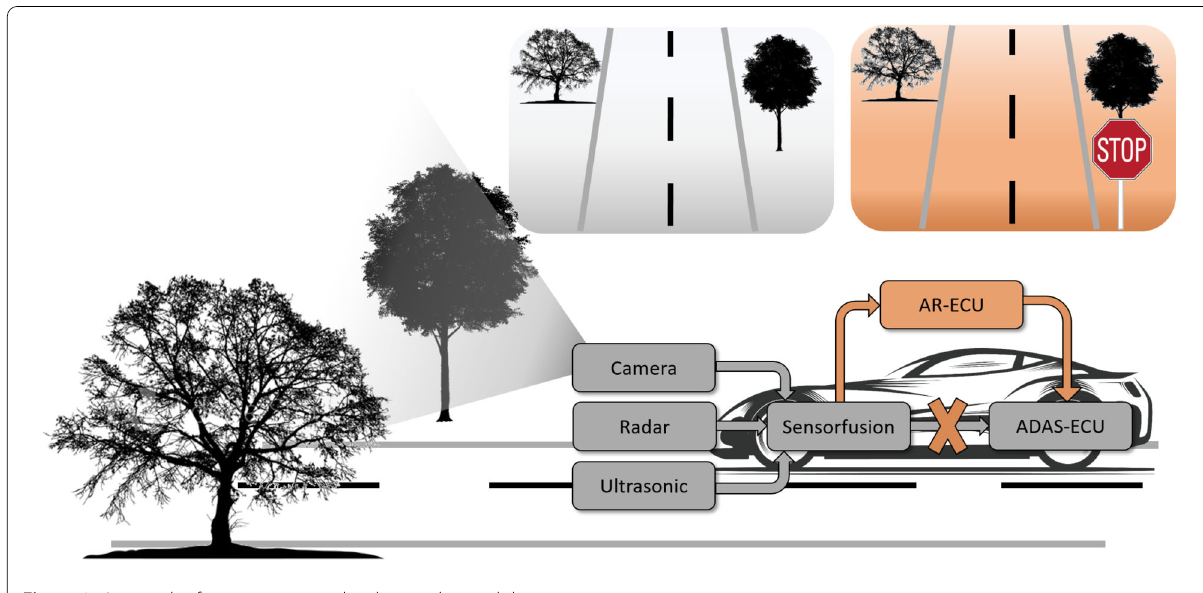
Figure 3 Approach of using augmented reality in advanced driver assistance systems